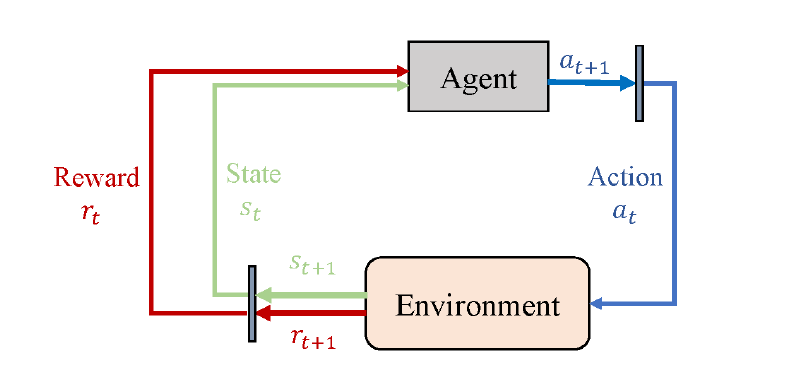
Figure 2. An illustration of Q-learning.